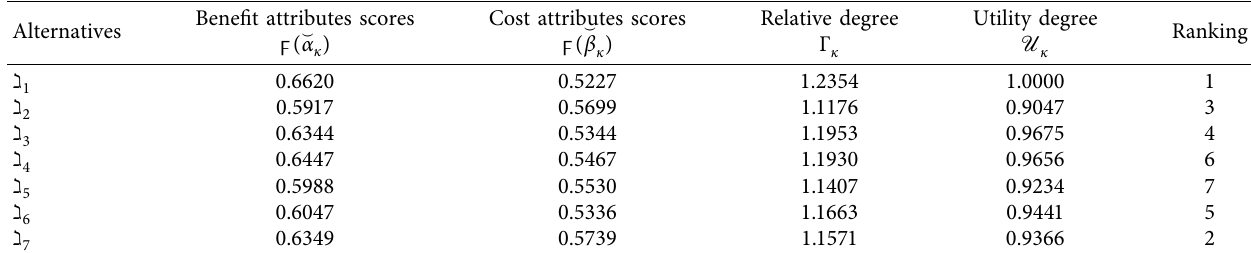
Table 10: Assessing outcomes of alternatives and ranking order by utilizing the 2TLC q -ROF-COPRAS. Alternatives